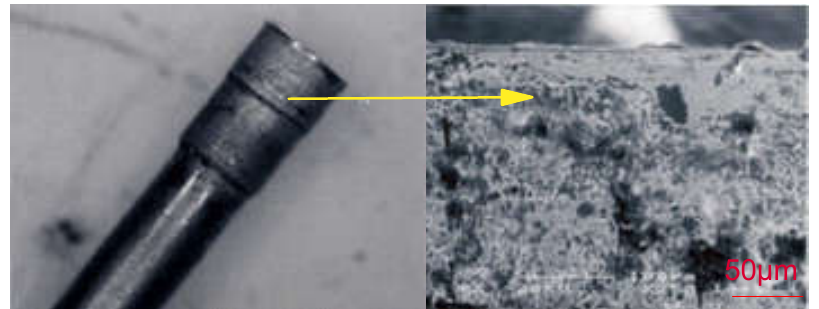
Figure 32. Pin removed after the Tuccillo–Nielsen test. Scale = 50 μm. Link sample #7 and pin sample #3.